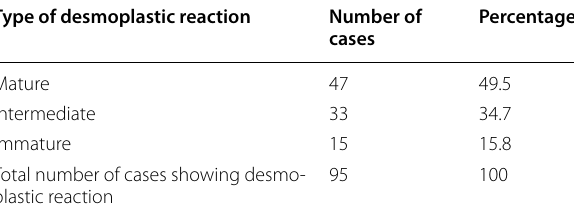
Table 1 Distribution of cases according to type of stromal desmoplastic reaction